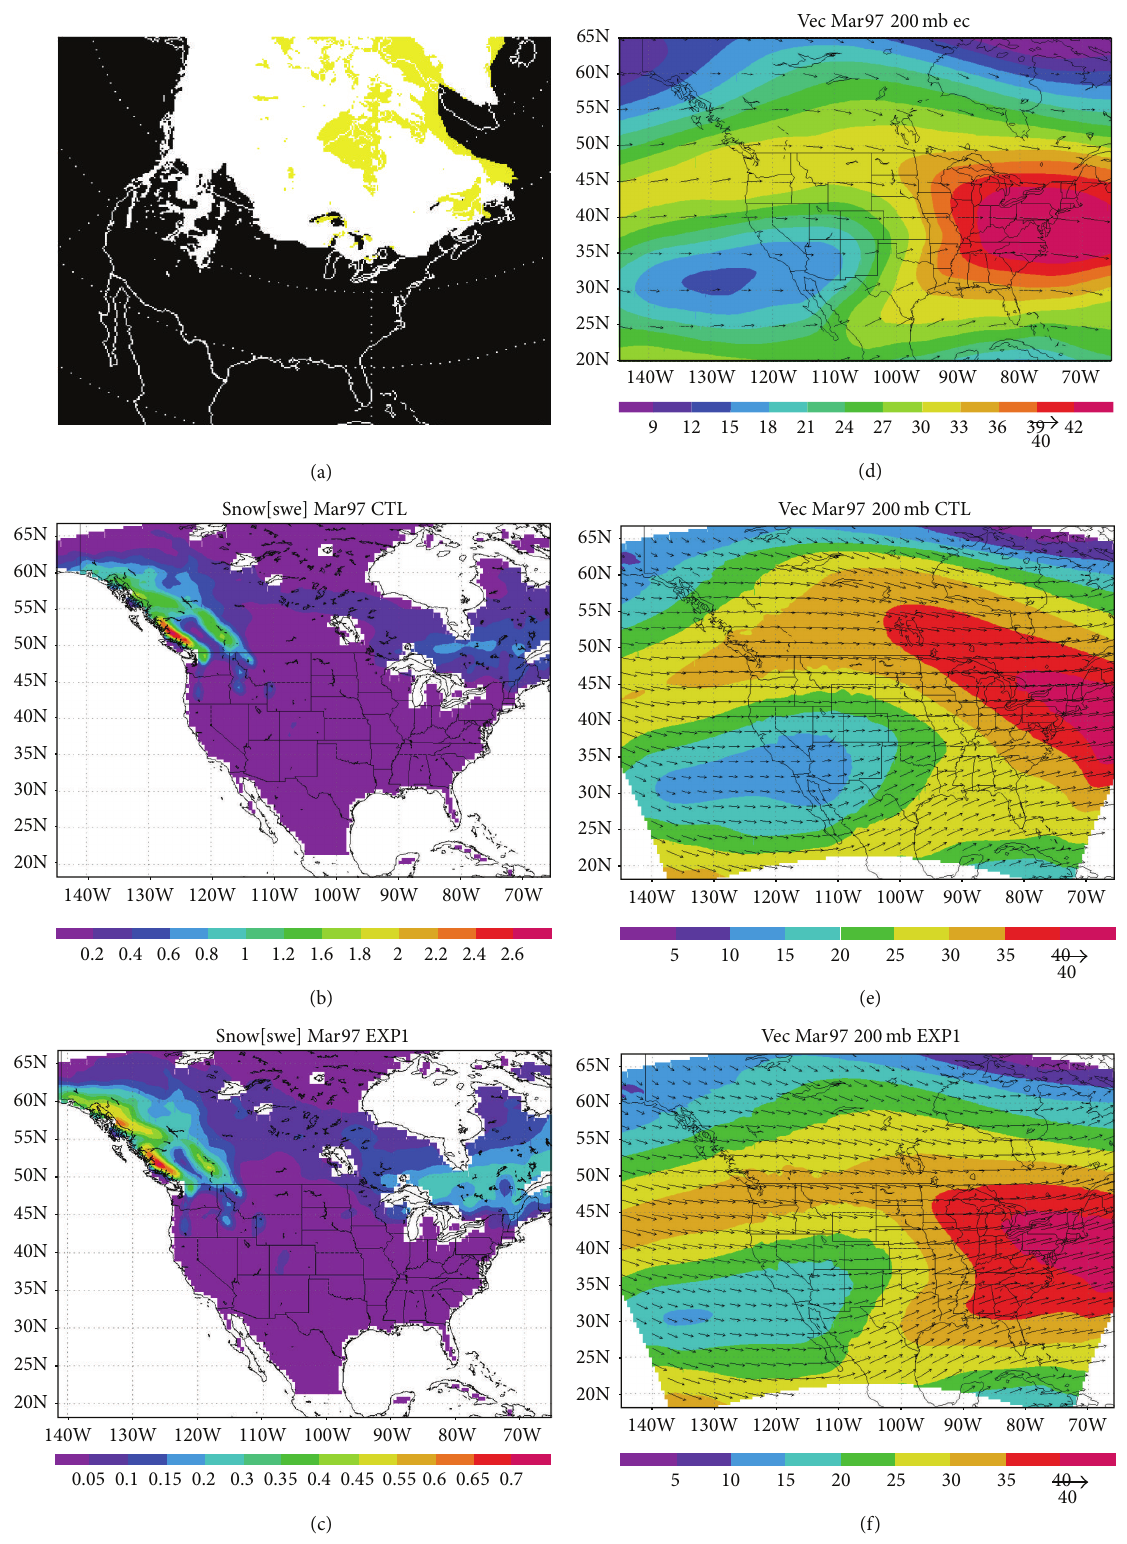
Figure 2: Left: observed (a) and simulated snow depth from CTL (b) and EXP1 (c). Right: monthly mean of 200 hPa wind vector for March 1997 from ECMWF (d), CTL (e), and EXP1 (f),